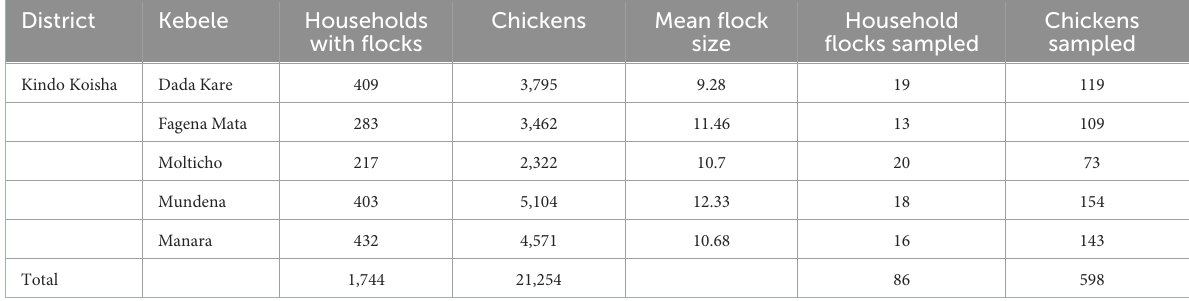
TABLE 1 Population of chickens and number of households per kebele. District Kebele Households